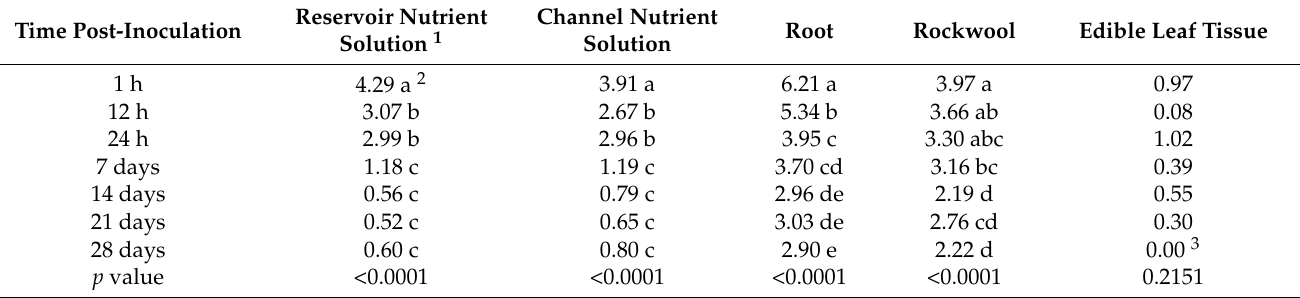
Table 1. Survival of Salmonella enterica serotype Typhimurium (LT2 JSG626) following the inoculation of the nutrient solution, simulating an extreme contamination event, in the reservoir and the channels, root, rockwool, and edible leaf tissue over a 28-day production cycle.